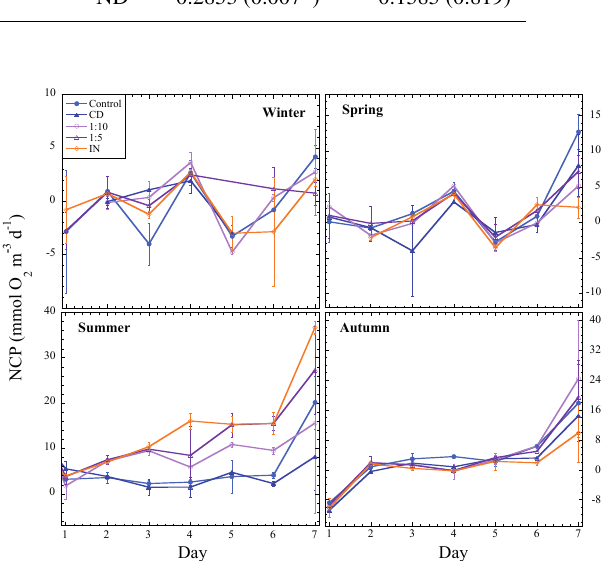
Figure 5. Net community production (NCP) in mmolO 2 m − 3 d − 1 measured the seven incubation days for the different treatments and